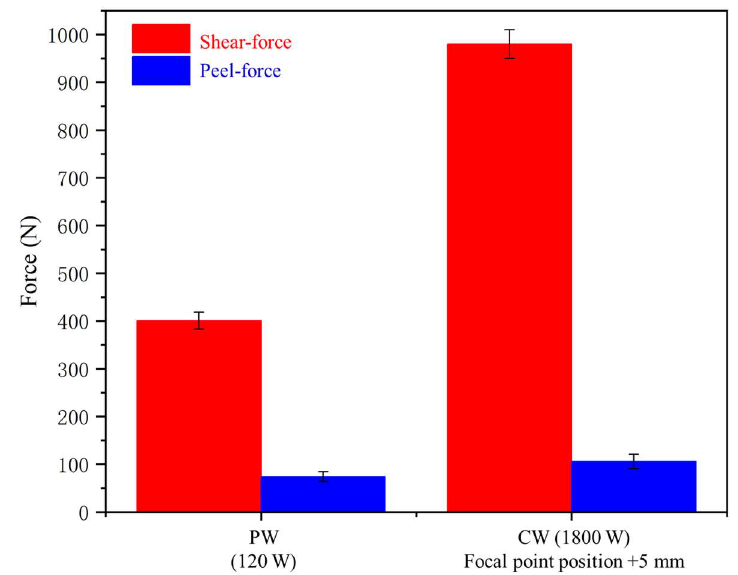
Figure 10. Results of shear test and 90-degree peel test.